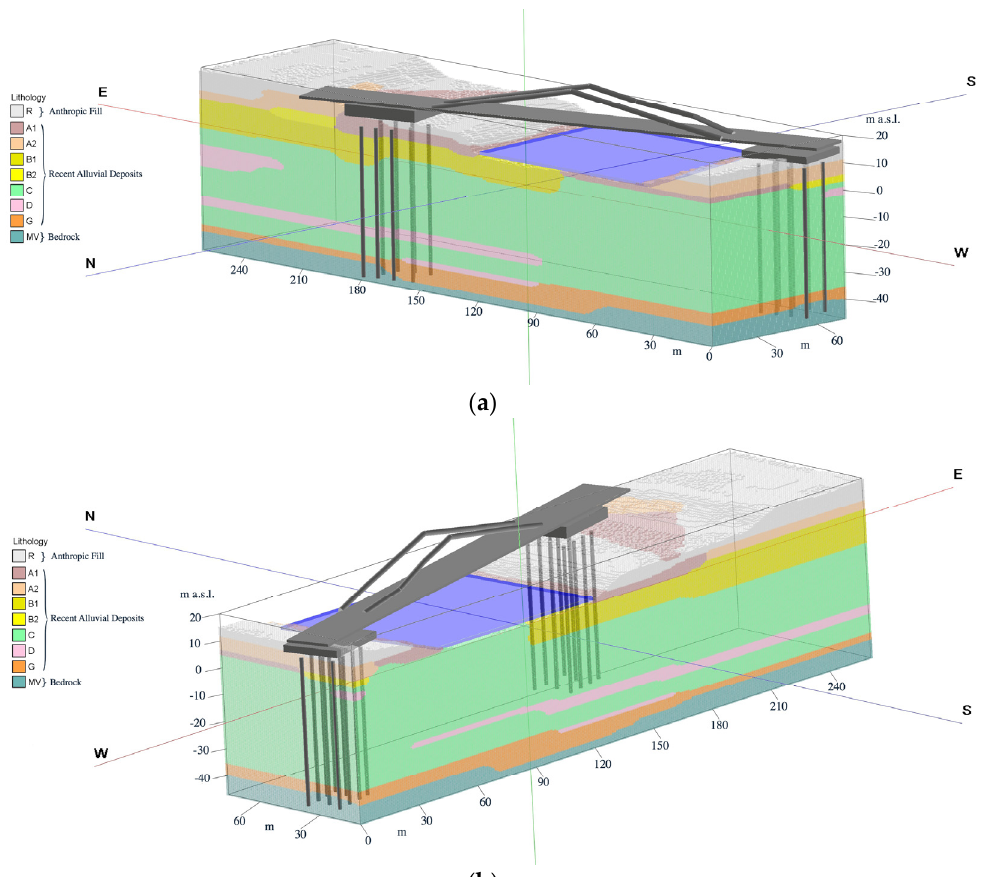
Figure 5. Three-dimensional geological model of the Ponte della Musica subsoil. In Figure 4 is the location of the area covered by the model. ( a ) View from NW; ( b ) view from SW.